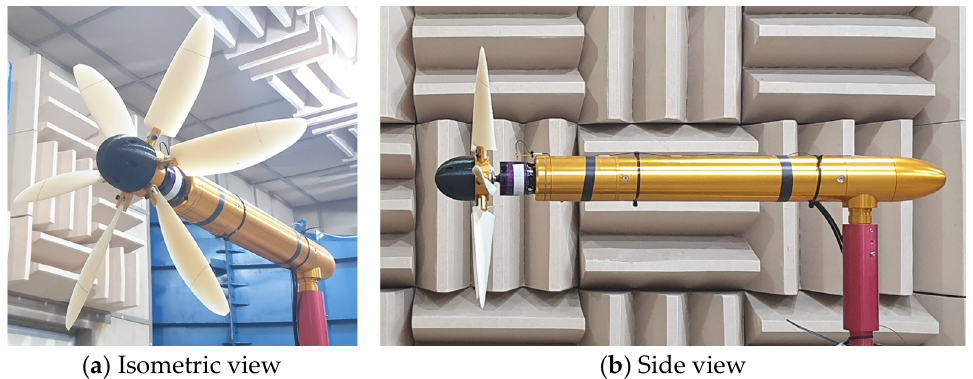
Figure 7. Model-scale propeller test rig for wind tunnel experiment.